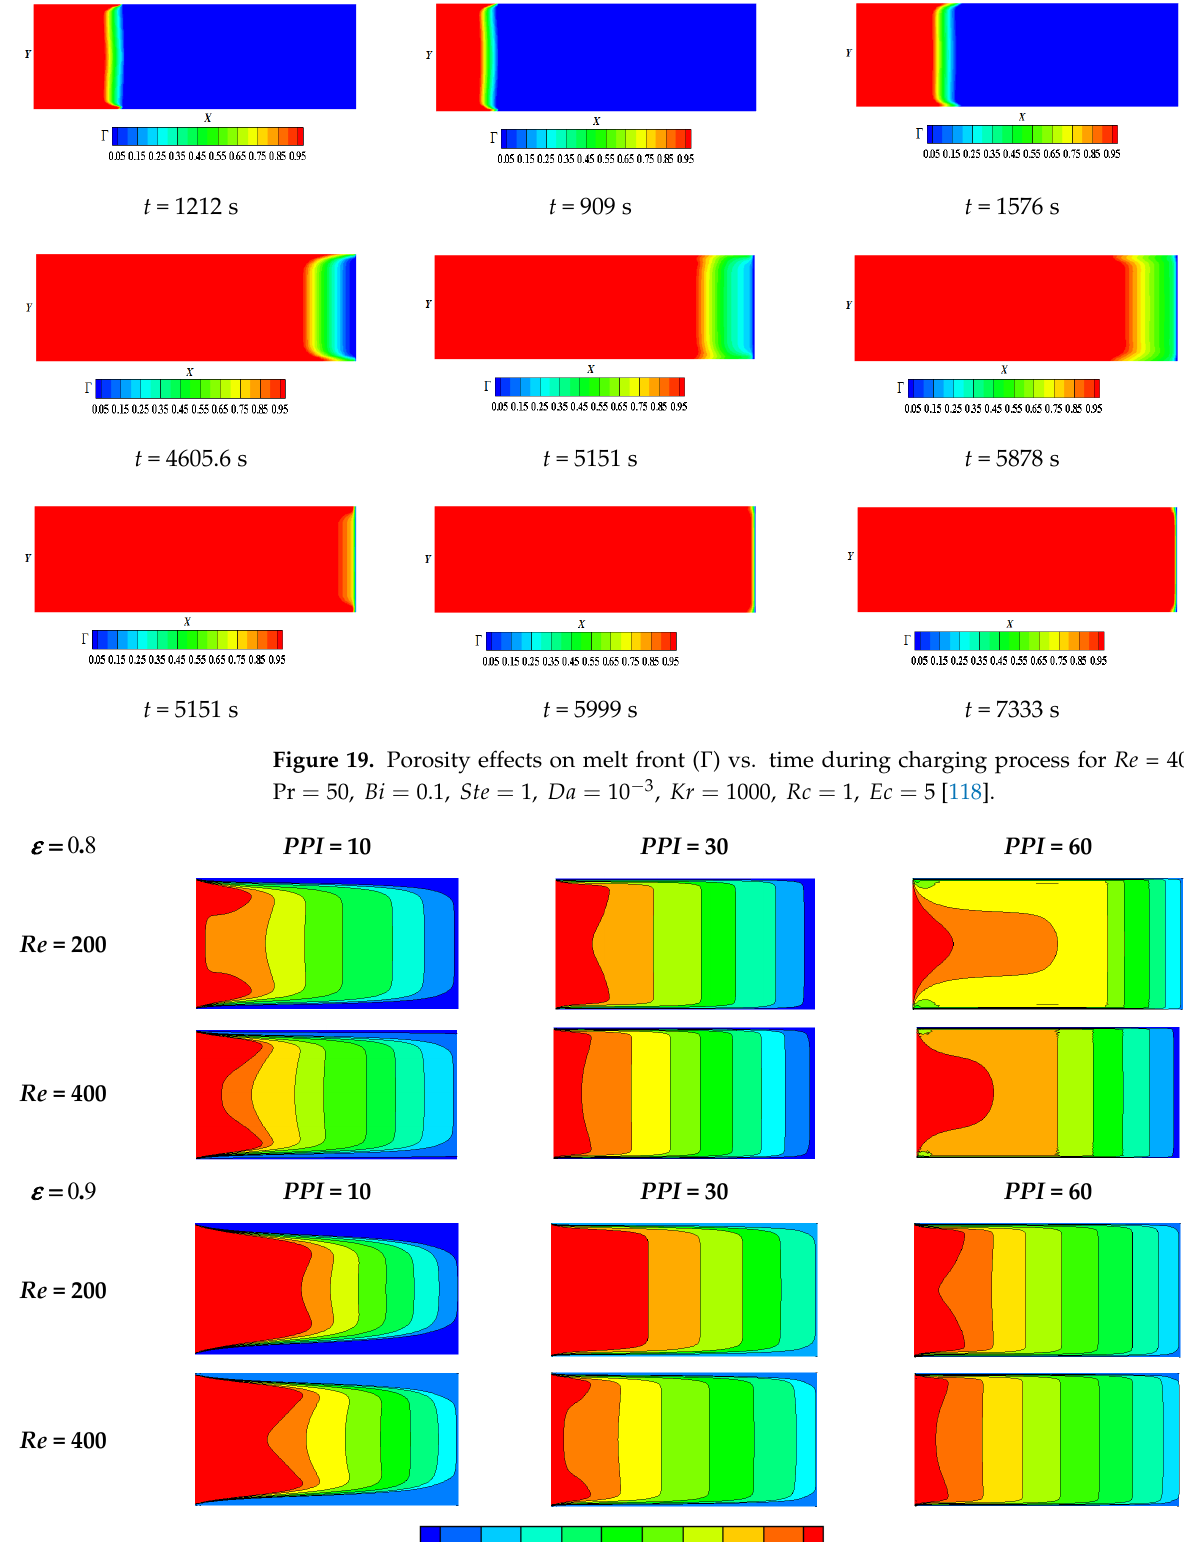
Figure 20. Pore density effect on U -contours during charging process at 0.8 ε = and 0.9 [119].